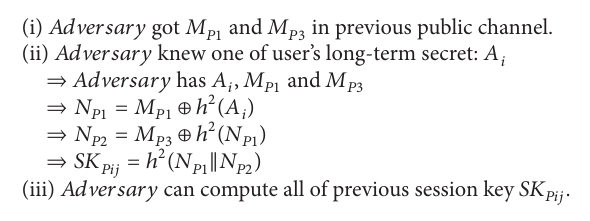
Algorithm 3: No perfect forward secrecy on Chuang and Chen’s